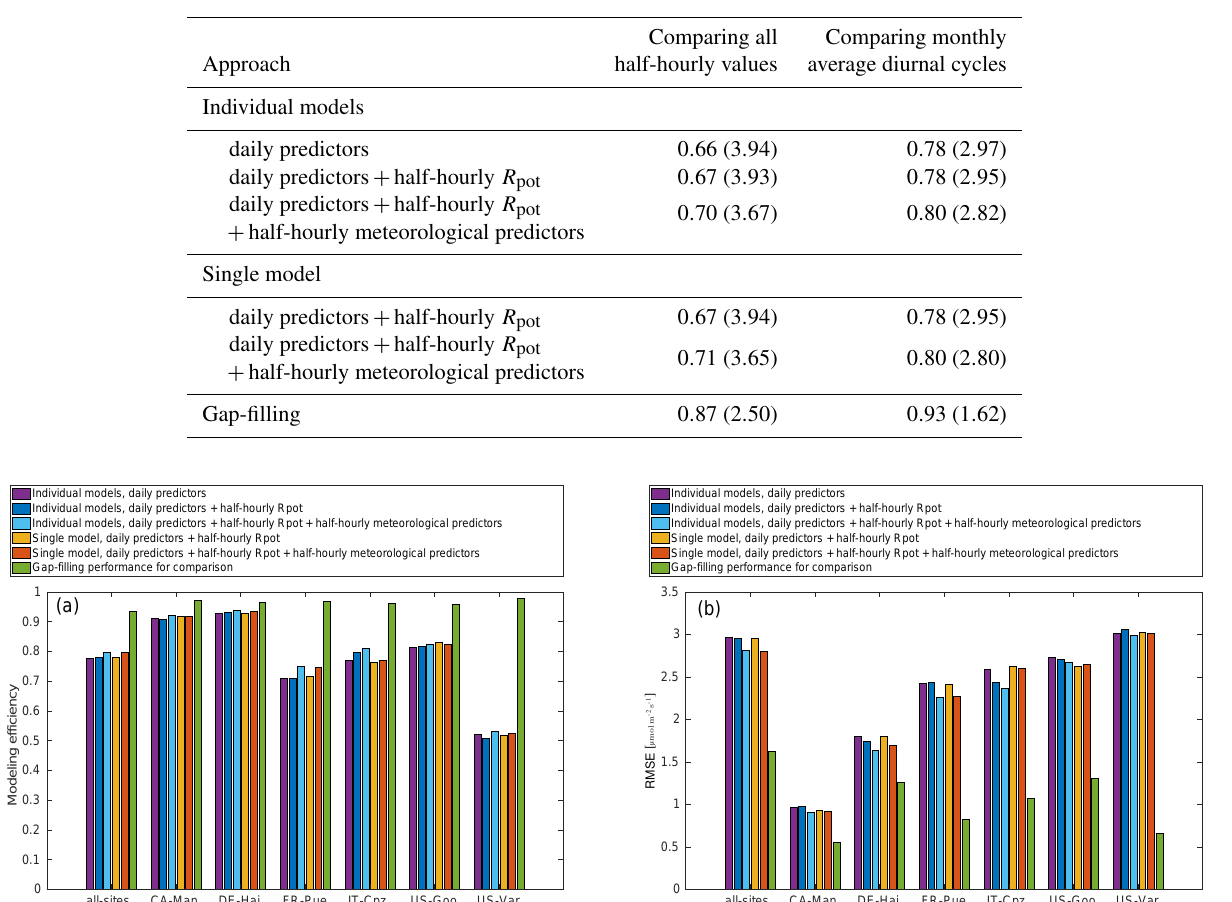
Table 1. Modeling efficiencies (and RMSE in µmolm − 2 s − 1 ) for the predictions of all sites obtained from the leave-one-site-out experiments are summarized and here we differentiate between comparing all individual half-hourly values with the observations and only looking at monthly average diurnal cycles.